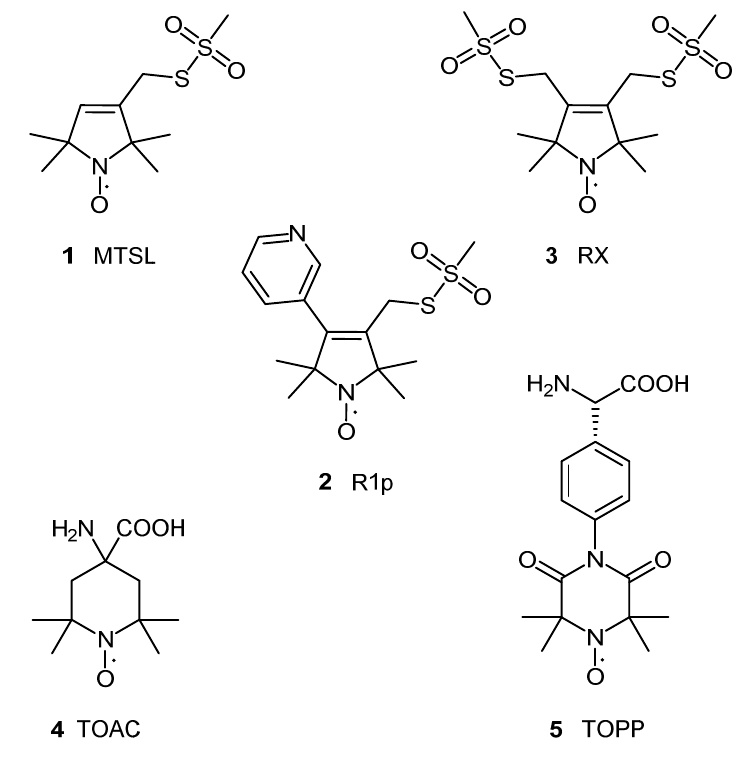
Figure 1. Structures of radical spin labels commonly used for SDSL of